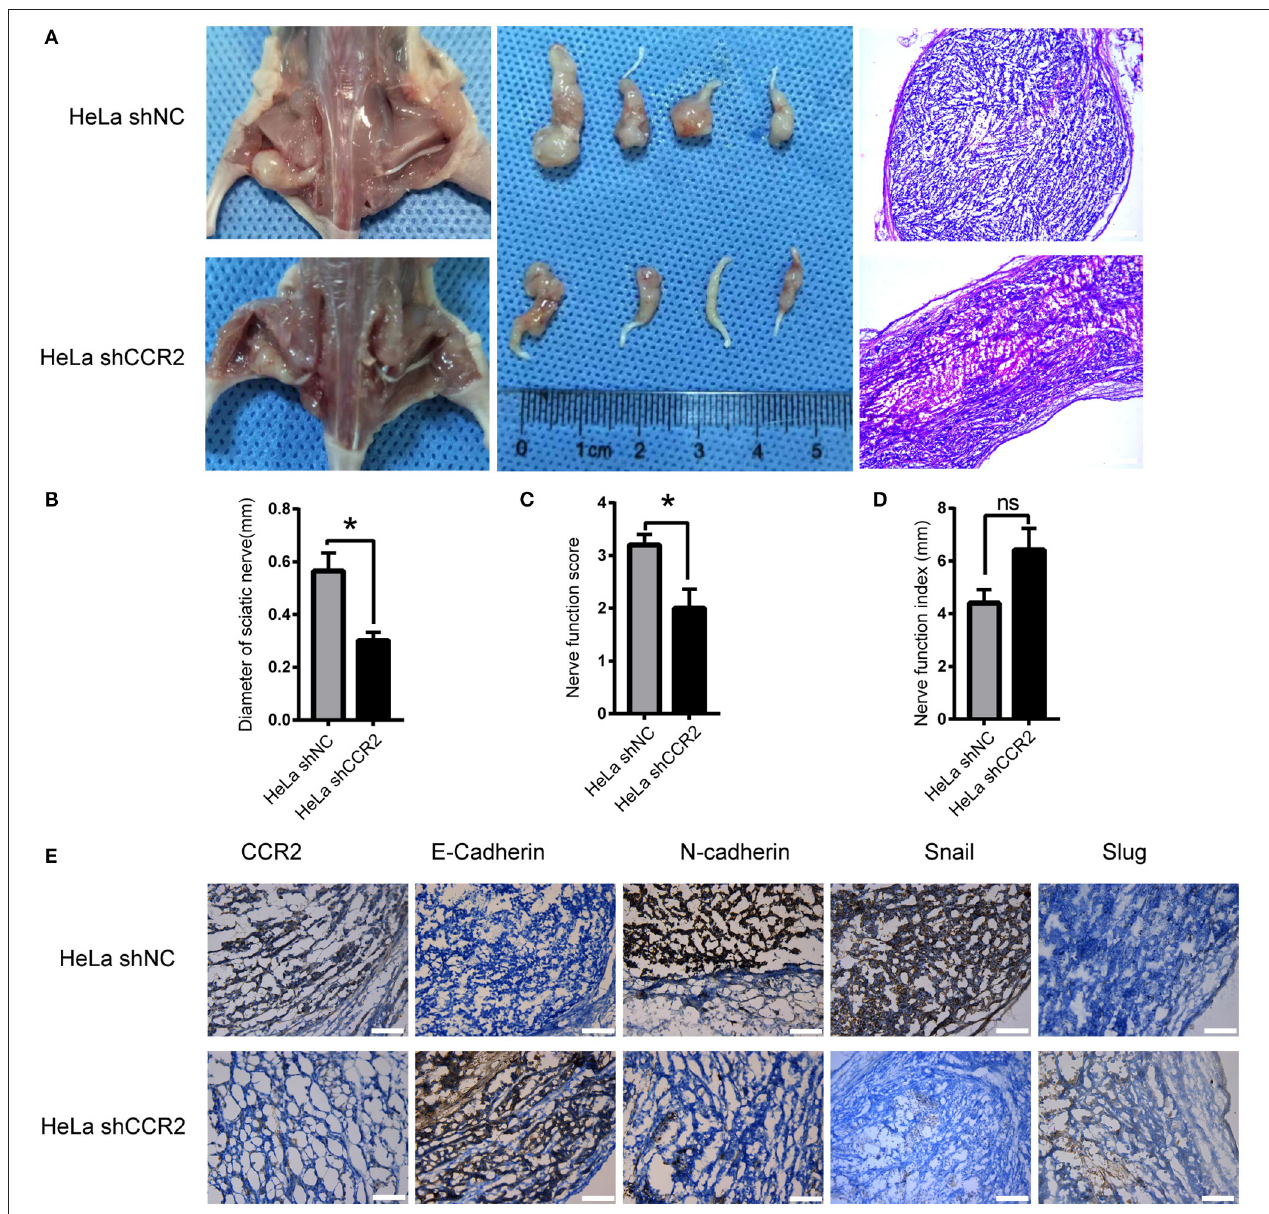
FIGURE 6 | Relationship between CCL2/CCR2 axis and PNI of cervical cancer in vivo . (A) Surgical images of the sciatic nerve. HeLa cells were injected into the left sciatic nerves. Mice treated with HeLa shCCR2 cells exhibited a smaller volume. The images to the right refer to the corresponding H&E staining results (50 × magnification, scale bar, 200 µ m). (B–D) Diameter of sciatic nerves, sciatic nerve function score and sciatic nerve function index of mice. (E) HeLa shNC cells injection resulted in the upregulation of N-cadherin and Snail. HeLa shCCR2 cells injection resulted in highly positive E-cadherin staining. * P < 0.05, ns , no significant. (200 × magnification, scale bar, 100 µ